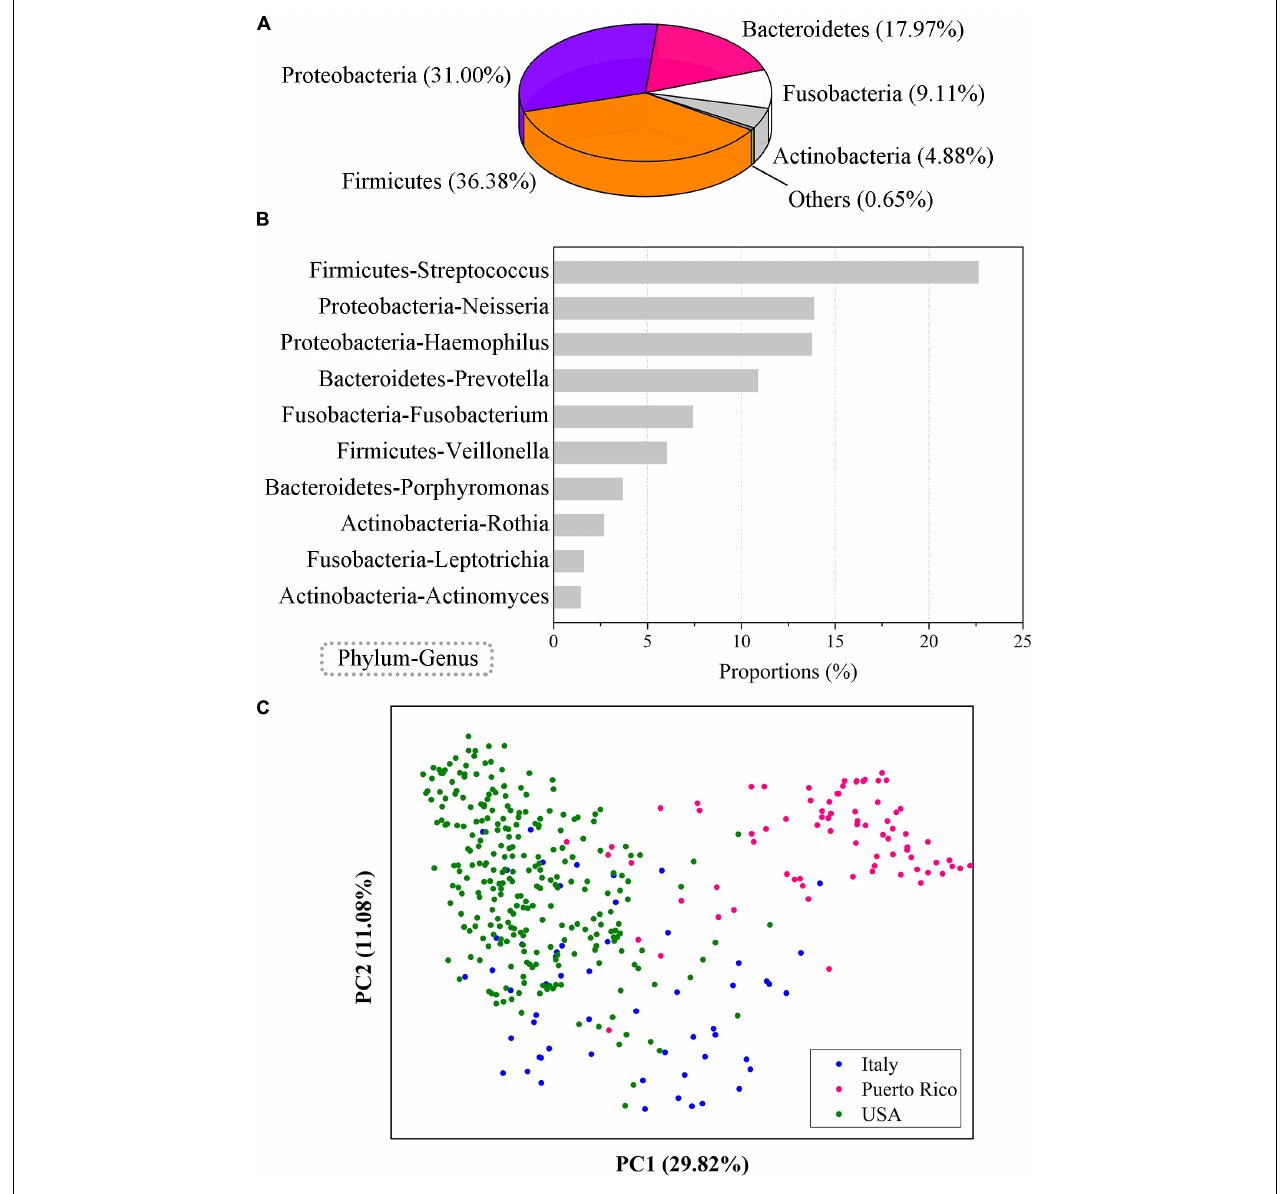
FIGURE 1 | Community composition of the human oral saliva microbiome. (A) Community composition of the human saliva microbiome at the phylum level. (B) Ten human saliva microbial genera with abundances over 1%. (C) PCoA analysis of the oral microbes from populations in different regions. The results were computed based on 404 EMP saliva samples from 3 regions, including 56 in Italy, 79 in Puerto Rico, and 269 in the United